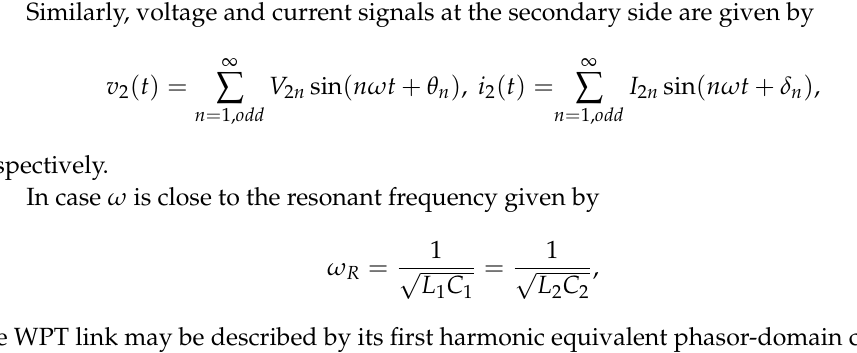
Figure 1. Series-series compensated inductive WPT link.